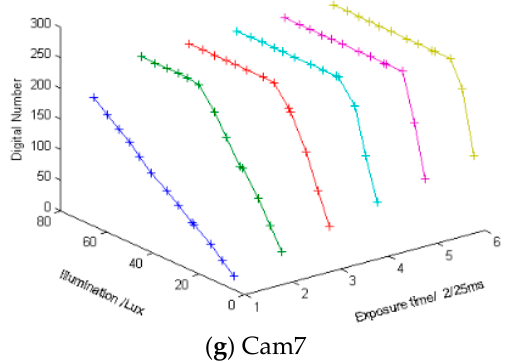
Figure 6. Red channel radiometric response of bear sensor with six exposure times (2/25 ms, 4/25 ms, 6/25 ms, 8/25 ms, 10/25 ms, and 12/25 ms), a digital gain ×1 and 0–80 lux illuminance. X ‐ axis is exposure time, and the unit is 2/25 ms, Y ‐ axis is illumination and the unit is lux, Z ‐ axis is mean value of red channel digital numbers. Table 1. Result of linear and four order polynomial fitting and evaluation.